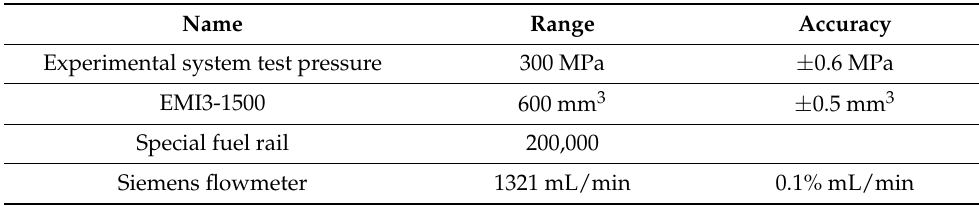
( b ) Comparison of injection duration. Figure 7. Comparison of 1D model and experiment.